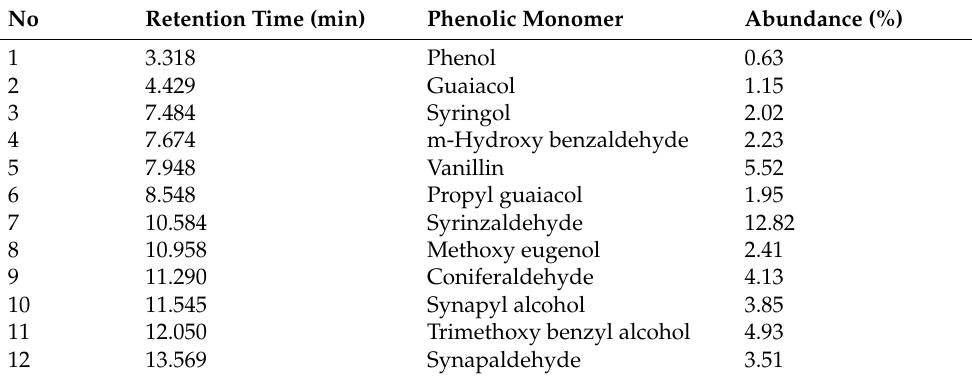
Figure 6. GC-MS total ion chromatogram of phenolic monomers from pine sawdust lignin. Table 3. Identified phenolic monomers and retention time of Pine sawdust Table 3. Identified phenolic monomers and retention time of Pine sawdust lignin.